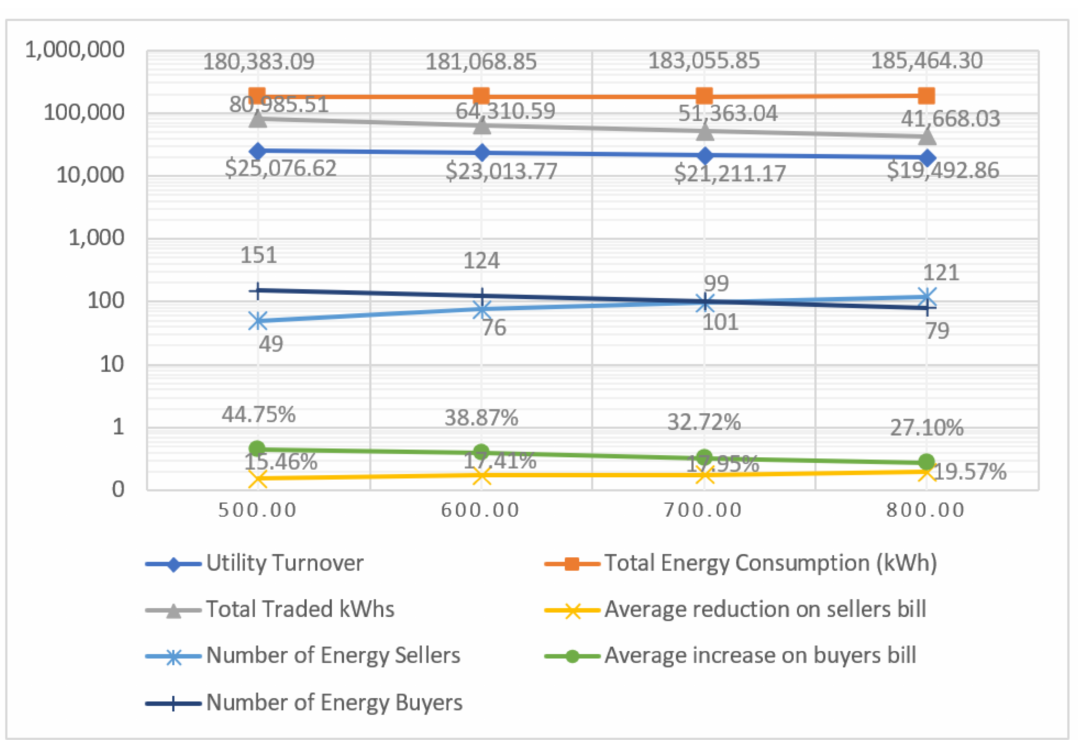
Figure 15. Energy Cap’s impact on the model’s